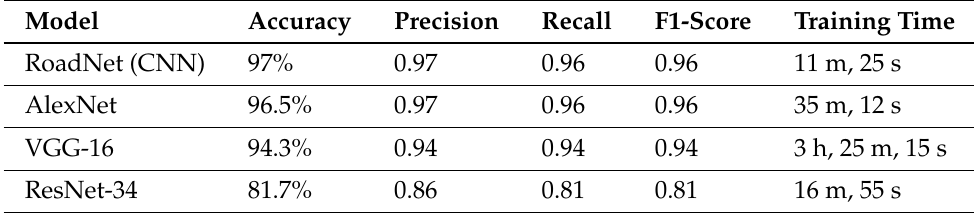
Table 7. Comparison between RoadNet, AlexNet, VGG-16, and ResNet-34 to classify road damage severity based on six different types of surface damage using our dataset.